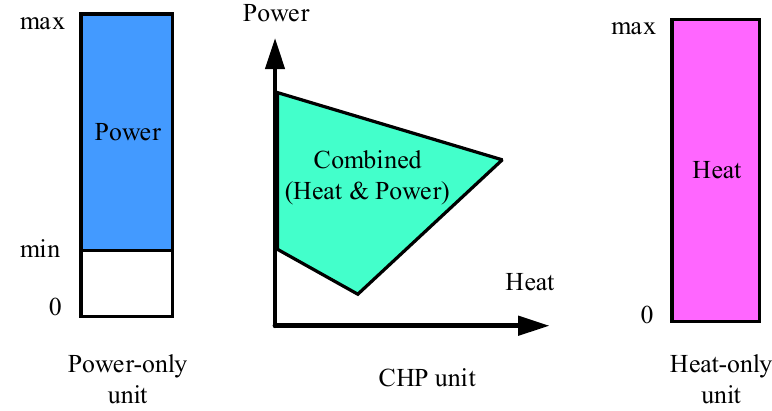
Figure 2. Feasible region of different units in the combined heat and power (CHP)-based system.